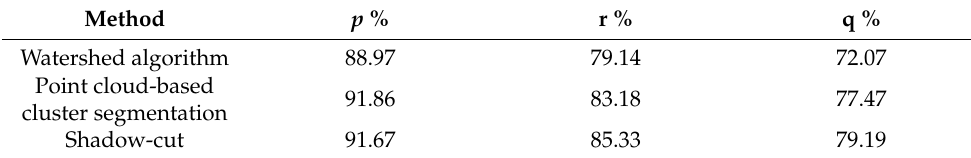
Table 3. Quantitative comparison between the proposed method and other methods.